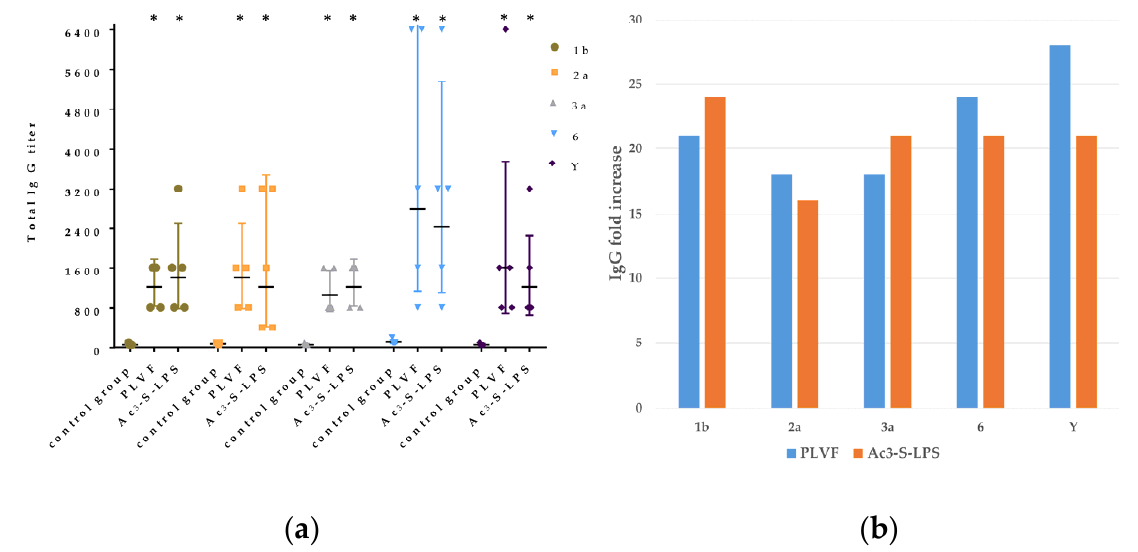
Figure 6. Comparative analysis of serotype-specific total IgG responses against PLVF at a dose of 125 μ g per mouse and its individual Ac 3 -S-LPS components at a dose of 25 μ g per mouse (Ac 3 -S-LPS 1b, 2a, 3a, 6, and Y). The immunogenicity of each Ac 3 -S-LPS was tested using wells coated with the corresponding antigen. ( a ) Total IgG titers in mice after immunization with PLVF or its individual components, ( b ) increase in specific IgG titers relative to unimmunized control group. (* p ≤ 0.05 compared with unimmunized control).